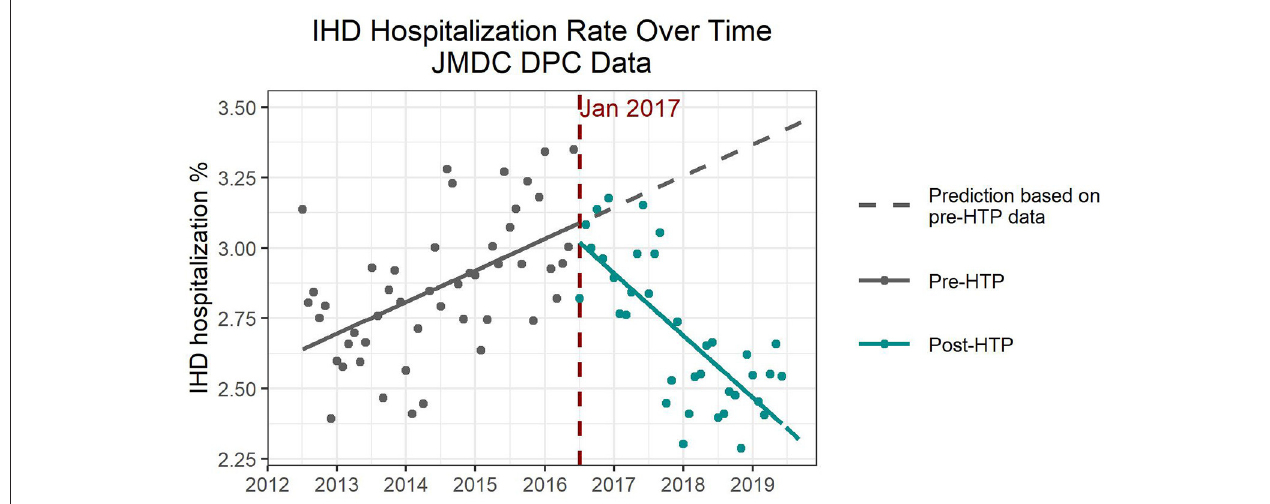
FIGURE 3 | Expected and observed trends in hospitalization numbers due to ischemic heart disease after introduction of heated tobacco products in Japan, using only Diagnosis Procedure Combination data.